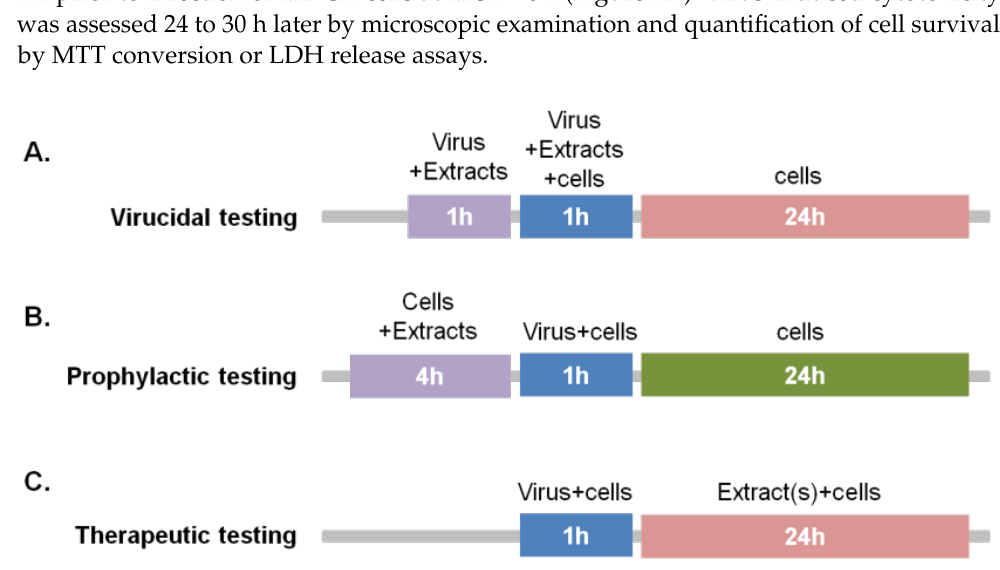
Figure 1. Schematic representation of the administration protocols used in this study. ( A ) Virucidal activity was tested by incubating the virus with plant extract for 1 h, prior to MDCK cell infection, as indicated. ( B ) Prophylactic testing was performed by pre-incubating MDCK cells with plant extract, infecting with H1N1 virus and measuring cell lysis 24 h post-infection. ( C ) Therapeutic activity was tested by infecting cells with the virus for 1 h and then applying the plant extract for 24 h prior to assessment of cell lysis by LDH release.